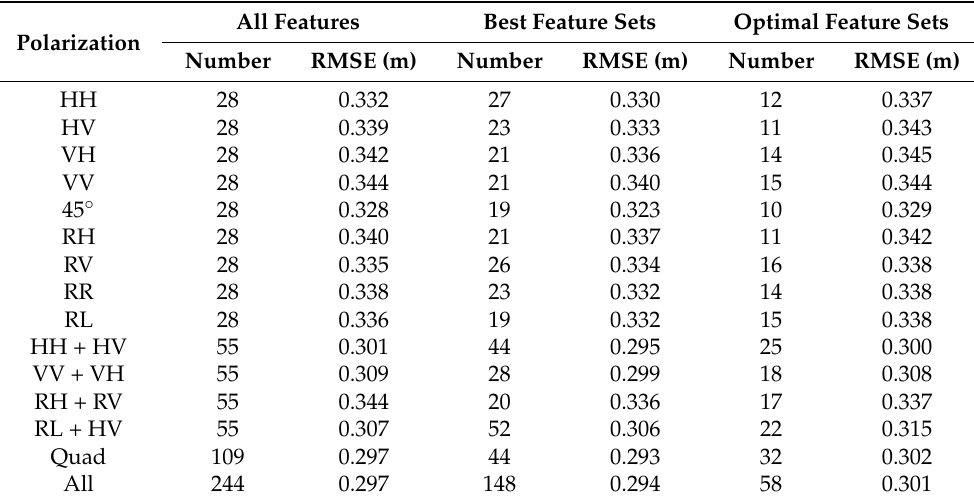
Table 2. The number of inputs and the performance of 15 polarization models for SWH retrieval using different input combinations, including all features extracted from SAR imagettes, the best feature sets, and the optimal feature sets. All Features Best Feature Sets Optimal Feature Polarization